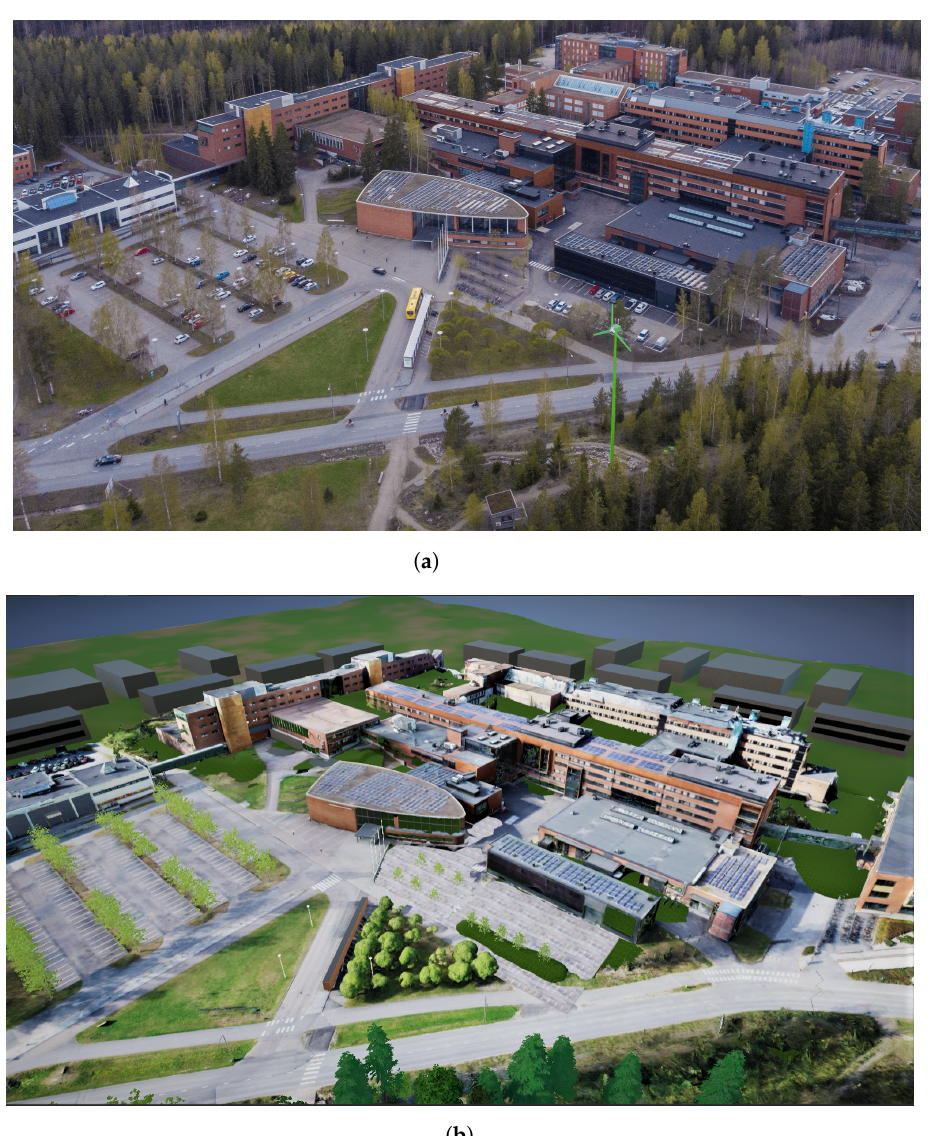
Figure 10. Comparison between the LUT University campus area in the real world and in Unity software using photogrammetry: ( a ) Real world and ( b ) Unity